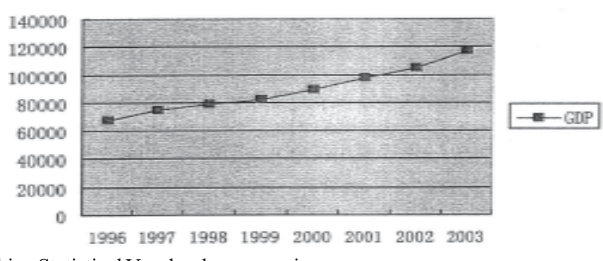
Figure 1 Growth trend of China’s GDP (in 100 mil. RMB, 1US Dollar=8.27 RMB)